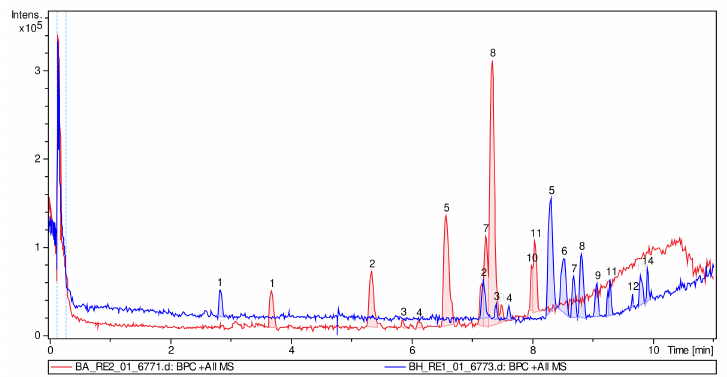
Figure 7. ESI–MS/MS total ion chromatogram profiles overlaid for DME (red) and PME